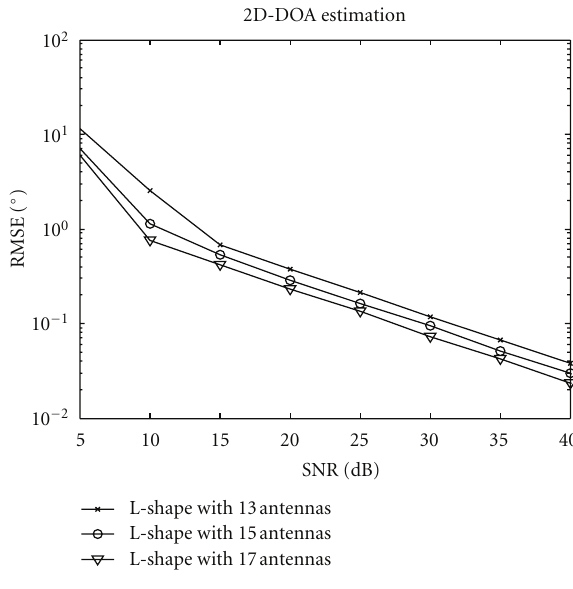
Figure 7: Angle estimation with di ff erent antennas.